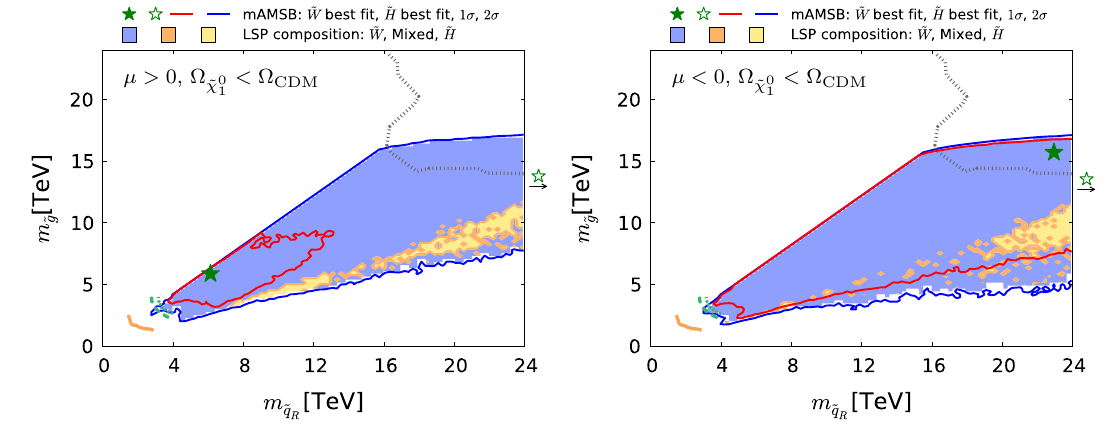
, m ˜ ) plane allowed in the (cid:4) ≤ 14-TeV data with 300 and 3000 f b − 1 , respectively. The grey dotted Fig. 21 The region of the ( m ˜ q ˜ χ 0 g R 1 μ > 0 ( left ) and μ < 0 ( right ). The orange solid line (cid:4) line is the 95% CL sensitivity expected at a 100 TeV pp collider with CDM case for a 3000 f b − 1 integrated luminosity obtained from [142]. All contours represents the LHC 8-TeV 95% CL exclusion [138]. The green dashed assume massless ˜ χ 0 . The shadings are the same as in Fig. 4 and dotted lines show the projection estimated by ATLAS [140] for 1